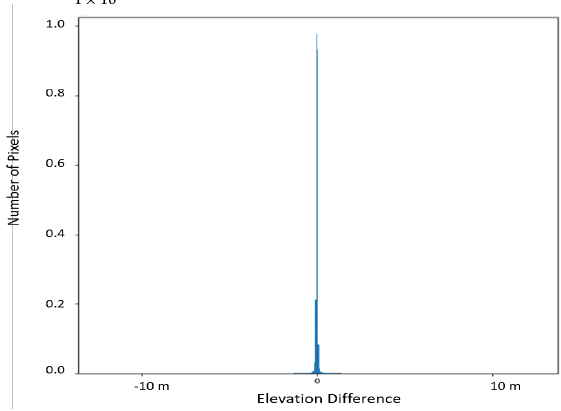
Figure 14. Height-difference histogram between DSMs from HR and